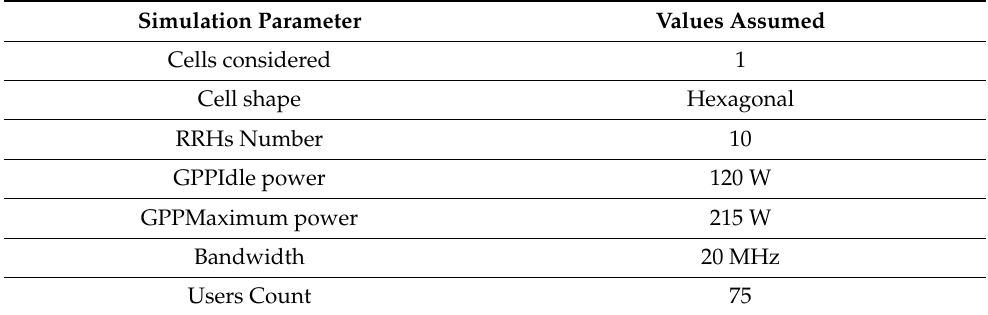
Table 1. Simulation parameter.